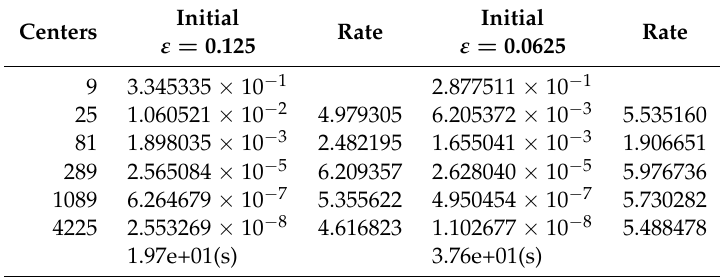
Table 10. H-RBFs collocation of example 1: with initial 0.125 and 0.0625.